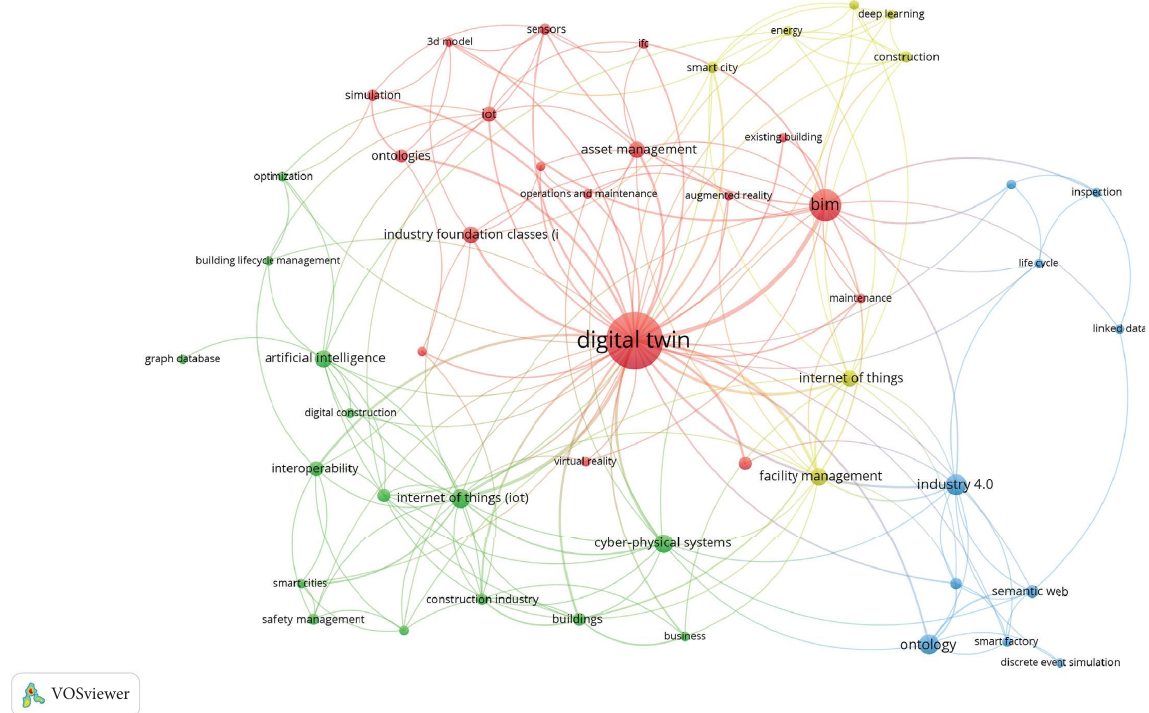
Figure 3: Network representation of keyword co-occurrence extracted from the Web of Science of Digital Twin research in the AEC-FM industry from 2016 to